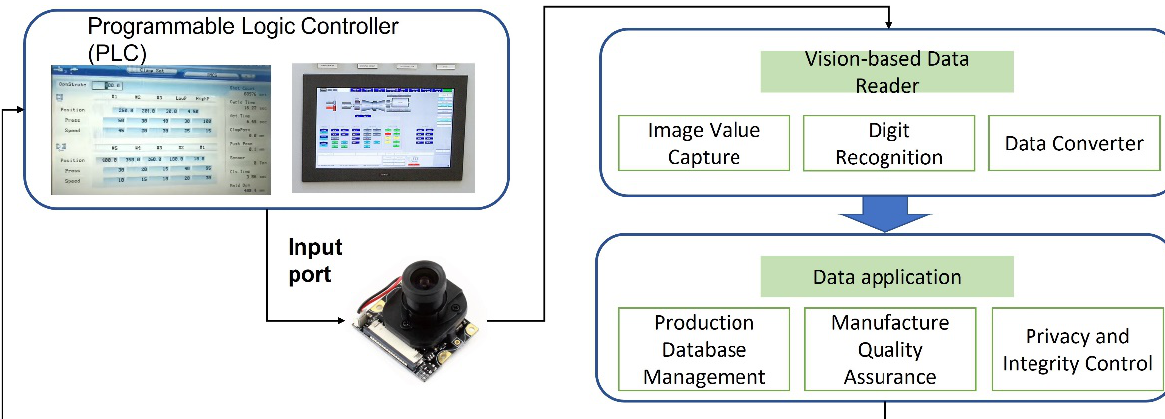
Figure 8. The vision-based data reader.